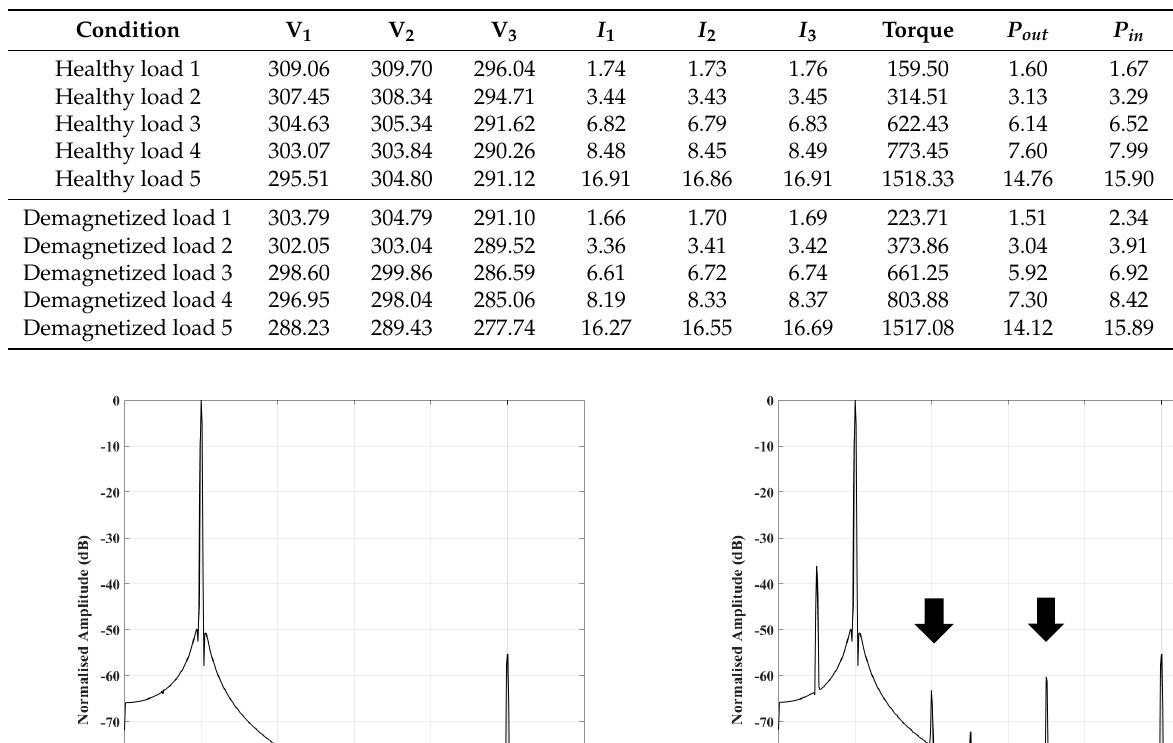
Table 4. Experimental measurement results.